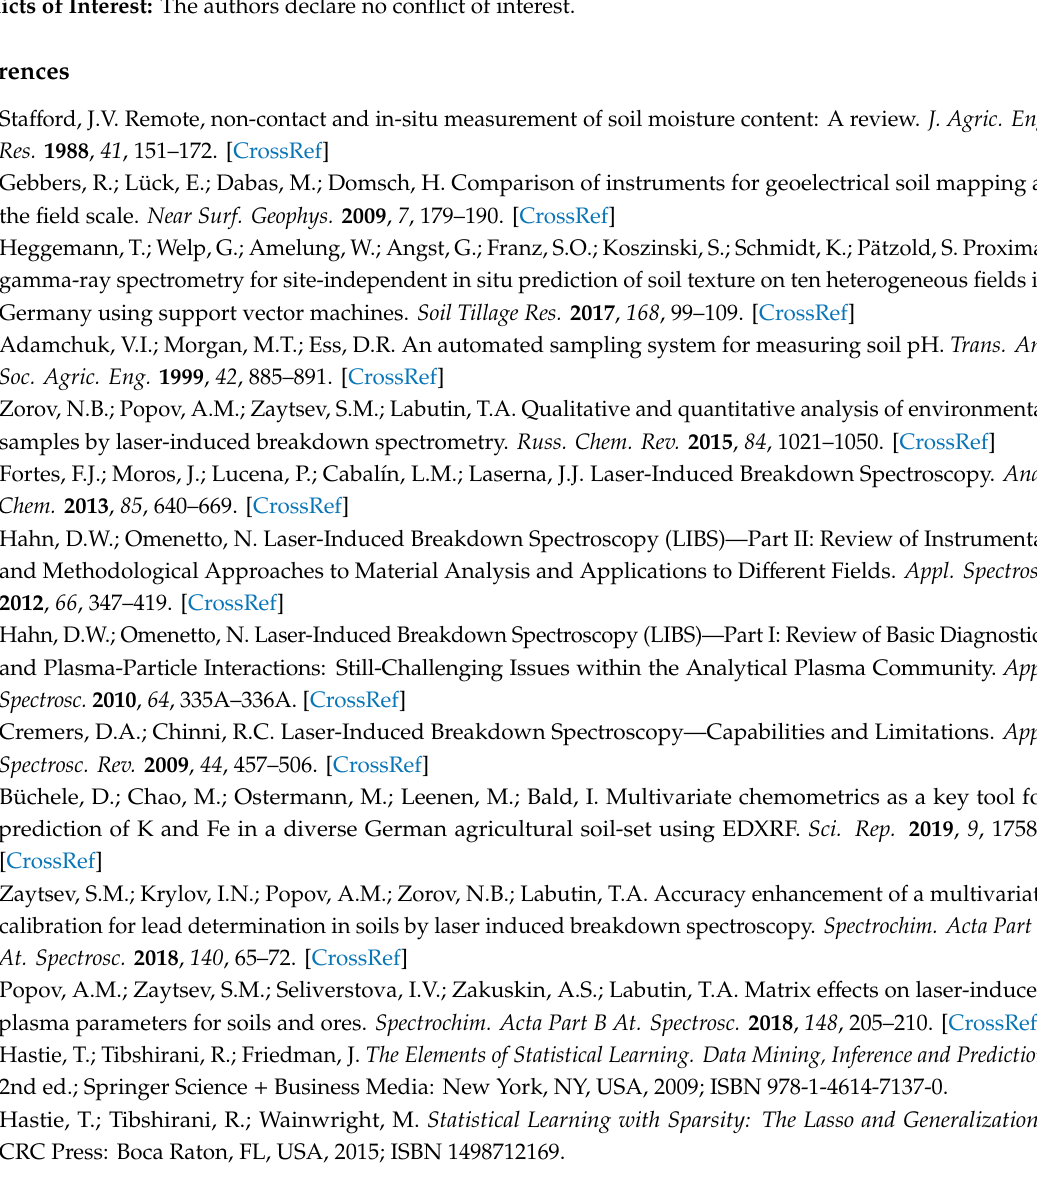
Table S1: Comparison of RMSEP of PLSR, Lasso and GPR methods, Figure S1: Results of 10-fold GPR cross validation for plant available P, R2(P, GPR) =